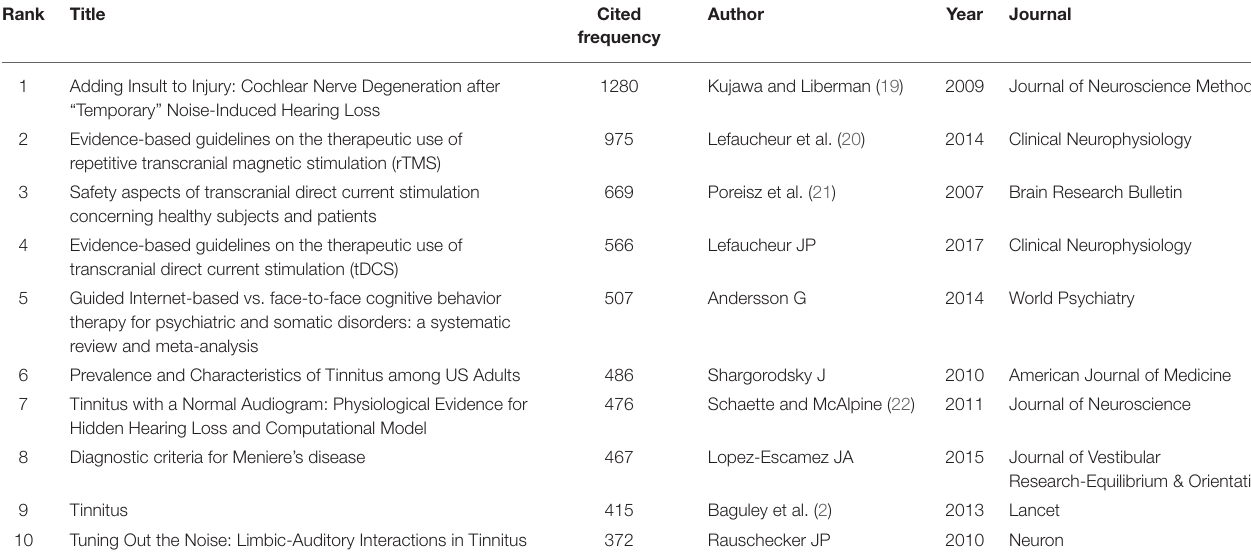
TABLE 5 | The top 10 most co-cited references on tinnitus research from 2001 to